Question: Write a single sentence explaining what this figure depicts.
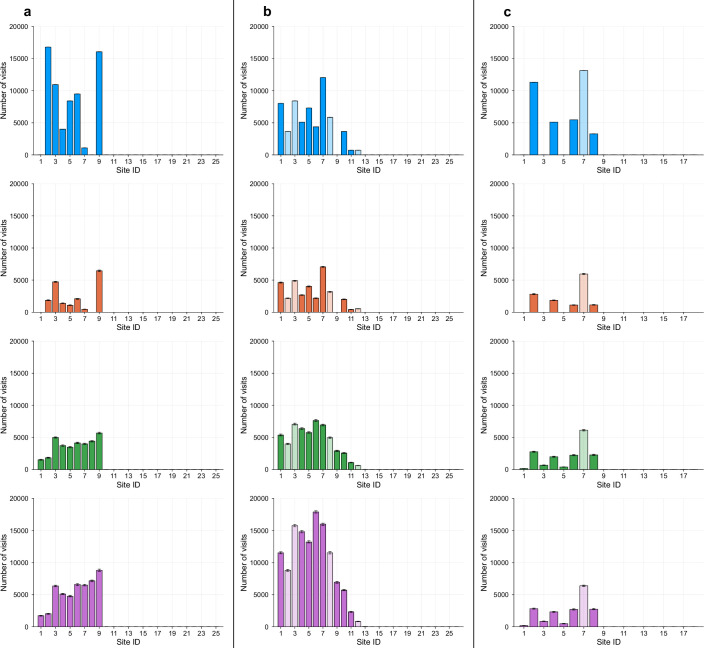
Answer: GPS logger data and processing. a , GPS logger data traces in Pakwach, aggregated across the study sample. GPS locations and movement are represented as purple lines). The blue triangles denote open-water sites mapped by the study team. The red triangles denote taps and boreholes. The red dashed line shows the study area. b , Number of distinct open-water sites visited by the study participants. c , Number of distinct taps and boreholes visited by the study participants. d , Processing steps to derive open-water-site and tap or borehole usage data from GPS data and household and site location data. e , Schematic of the data frame resulting from the processing, which was used to fit spatial decay models. The columns represent the unique individual identifier (Ind.), type of water feature (open-water site or tap or borehole), water feature ID, whether the individual had any contact with the feature during the observation period (1 = yes and 0 = no) and Euclidean distance (Dist.) to the feature from the household location of the individual. Uganda waterbodies shapefile from World Resources Institute ( https://www.wri.org/ ) 70 . House icon adapted from Firkin/Openclipart.